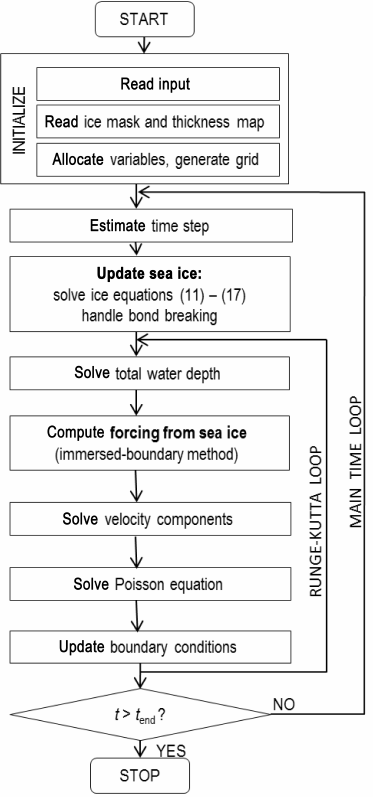
Figure 3. Simplified flowchart of the coupled wave–ice model.